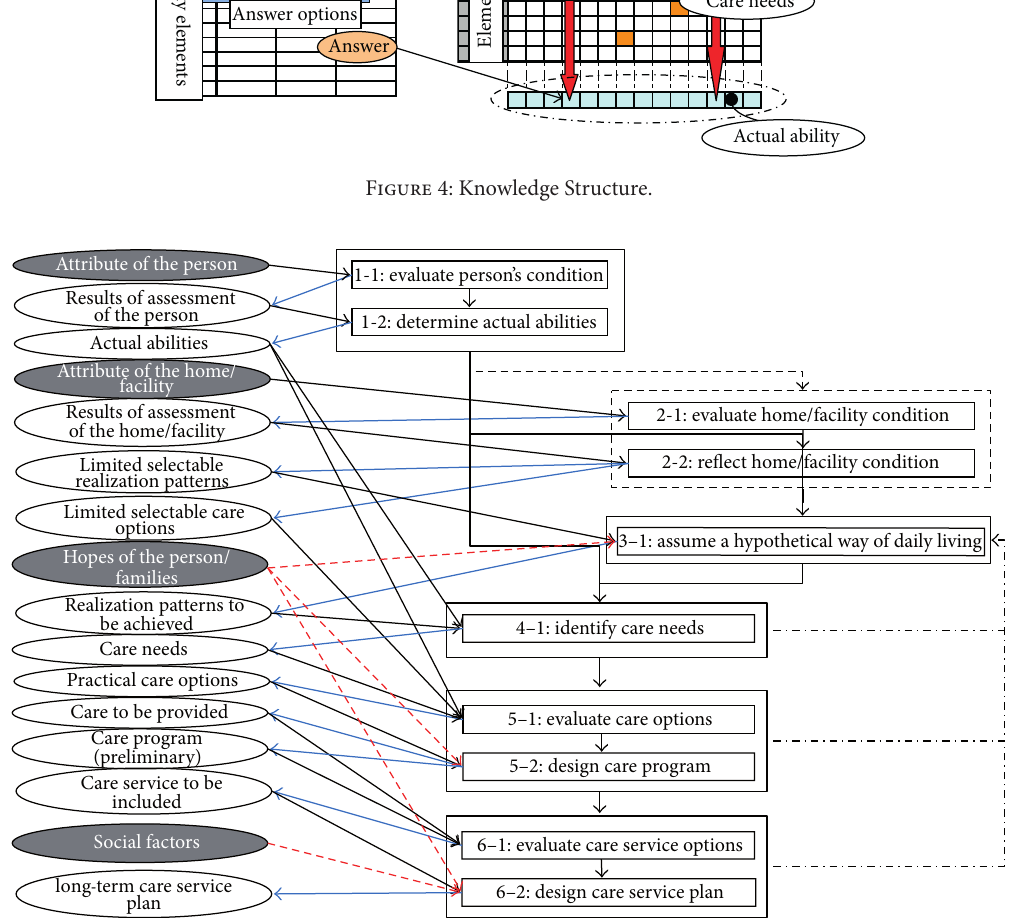
In this realization pattern, element actions like “getting upper clothes on,” “doing up buttons, zipping up,” and so forth and ability elements like “ability to move one’s hand to bosom,” “ability to move one’s hand to back,” “ability to move weighing object,” “skill with the hand,” and so forth are included. Care need is identified for the element action “doing up buttons, zipping up” on ability element “skill with hand,” because the required ability for this element action on this ability element is set as 4, which is higher than the actual ability assessed as